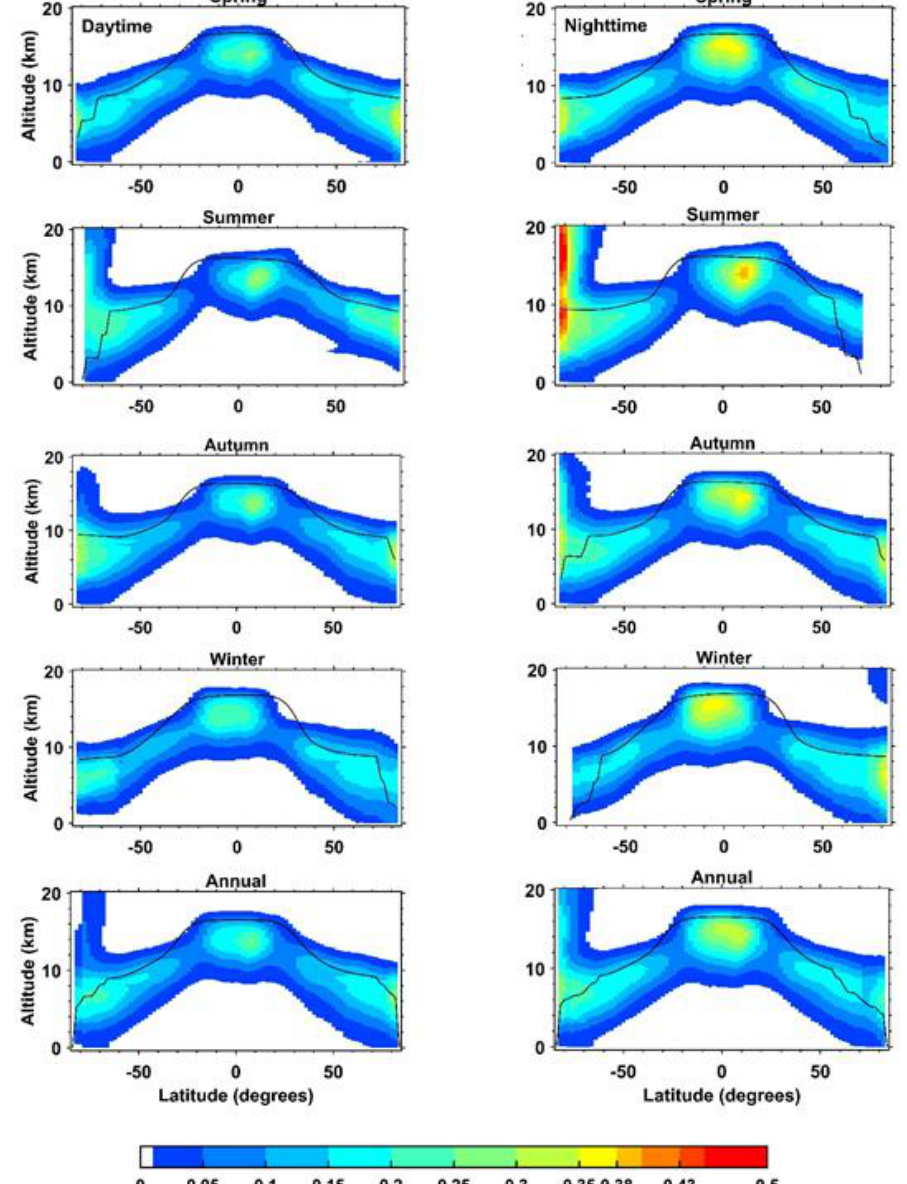
Figure 1. Seasonal and annual distributions of the 10-year mean ice cloud fraction (ICF) over latitude during the daytime (left panels) and nighttime (right panels) for four seasons observed from the CALIOP. The white color represents the value of less than 0.01. The solid black line refers to tropopause height.